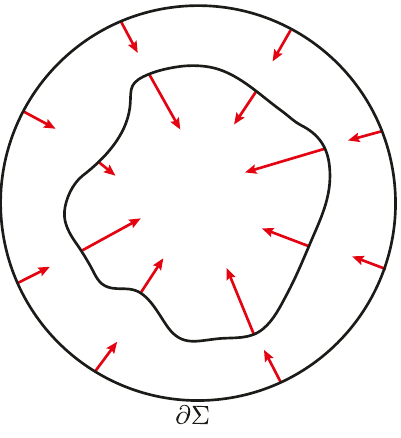
Figure 2 . The canonical C -field in 2+1 dimensions is orthogonal to surfaces conformal to